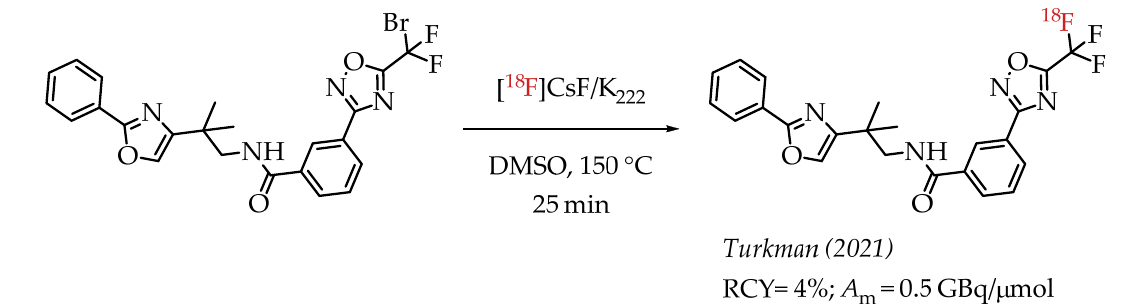
Scheme 7. Turkman’s synthesis of [ 18 F]TMP195. (RCY: radiochemical yield; A m : molar activity.)